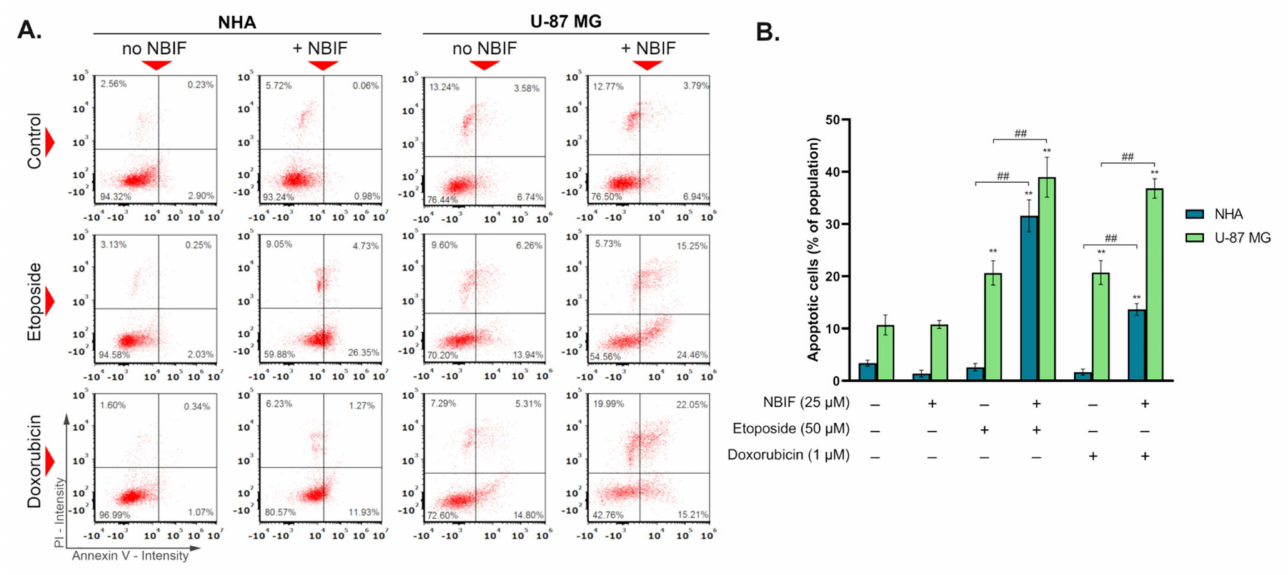
Figure 2. The results of Annexin V assay after 48 h of the incubation of NHA human astrocytes and U- 87 MG glioblastoma cells with etoposide (50 µ M) or doxorubicin (1 µ M) alone and in combination with NBIF (25 µ M). ( A ) Representative scatter plots present cell population divided into four quadrants: healthy cells (lower left), early apoptotic cells (lower right), late apoptotic cells (upper right) and non-apoptotic dead cells (upper left). ( B ) Mean values and SD of percentage of the annexin V-positive cells (bar graph) from three independent experiments in at least triplicate. The results are presented as percent of whole population. ** p < 0.001 vs. control; ## p < 0.001 for comparisons between groups. PI—propidium